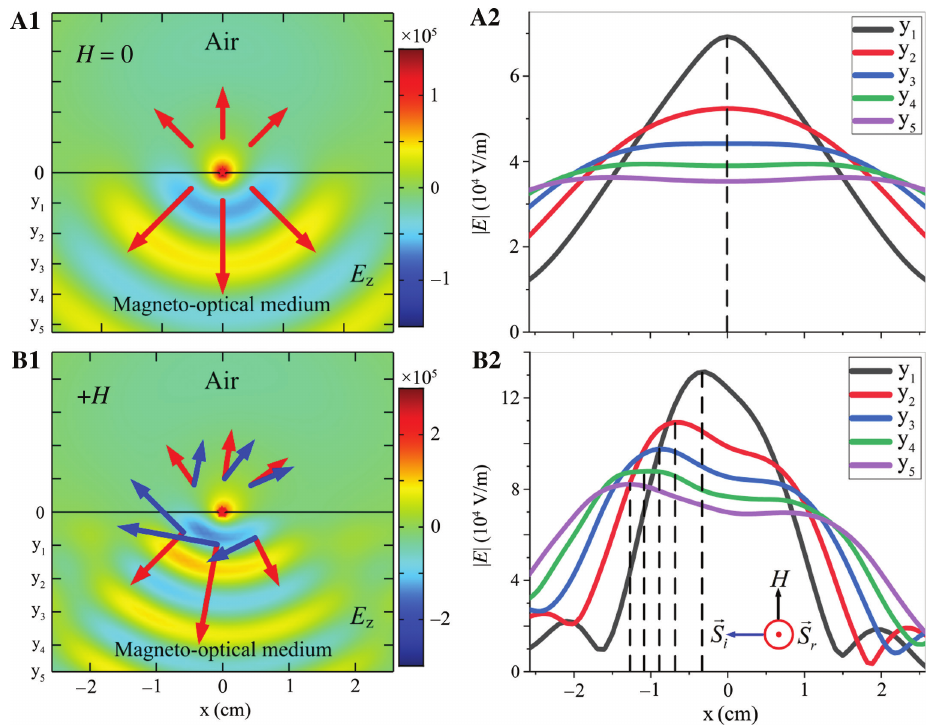
Figure 4: Numerical simulation results in semi-infinite systems. (A1) H = 0, (A2) | E | at different y source radiates at f